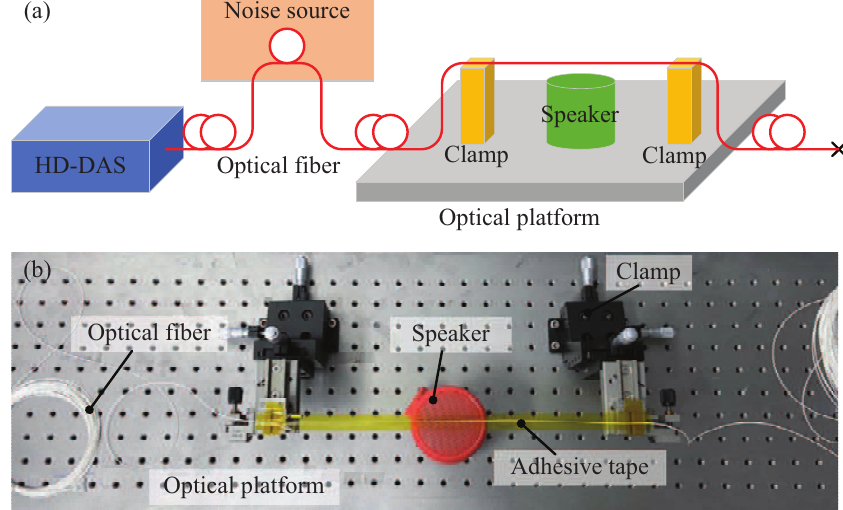
Figure 10. The experimental configuration using the HD-DAS system for sound detection. ( a ) schematic diagram; ( b ) real system in the